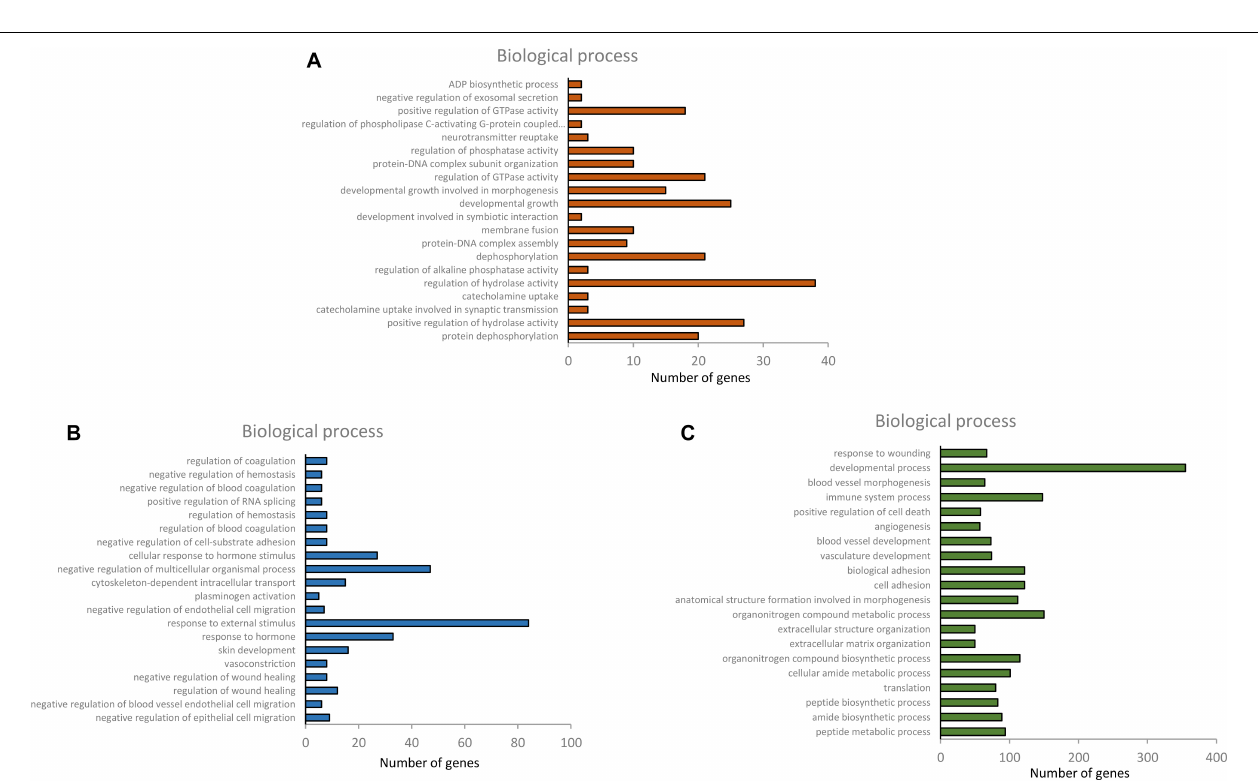
FIGURE 4 | Top 20 BP terms of gene ontology of differentially expressed genes in hypothalamus, pituitary and ovary [ (A) hypothalamus, (B) pituitary, and (C) ovary].